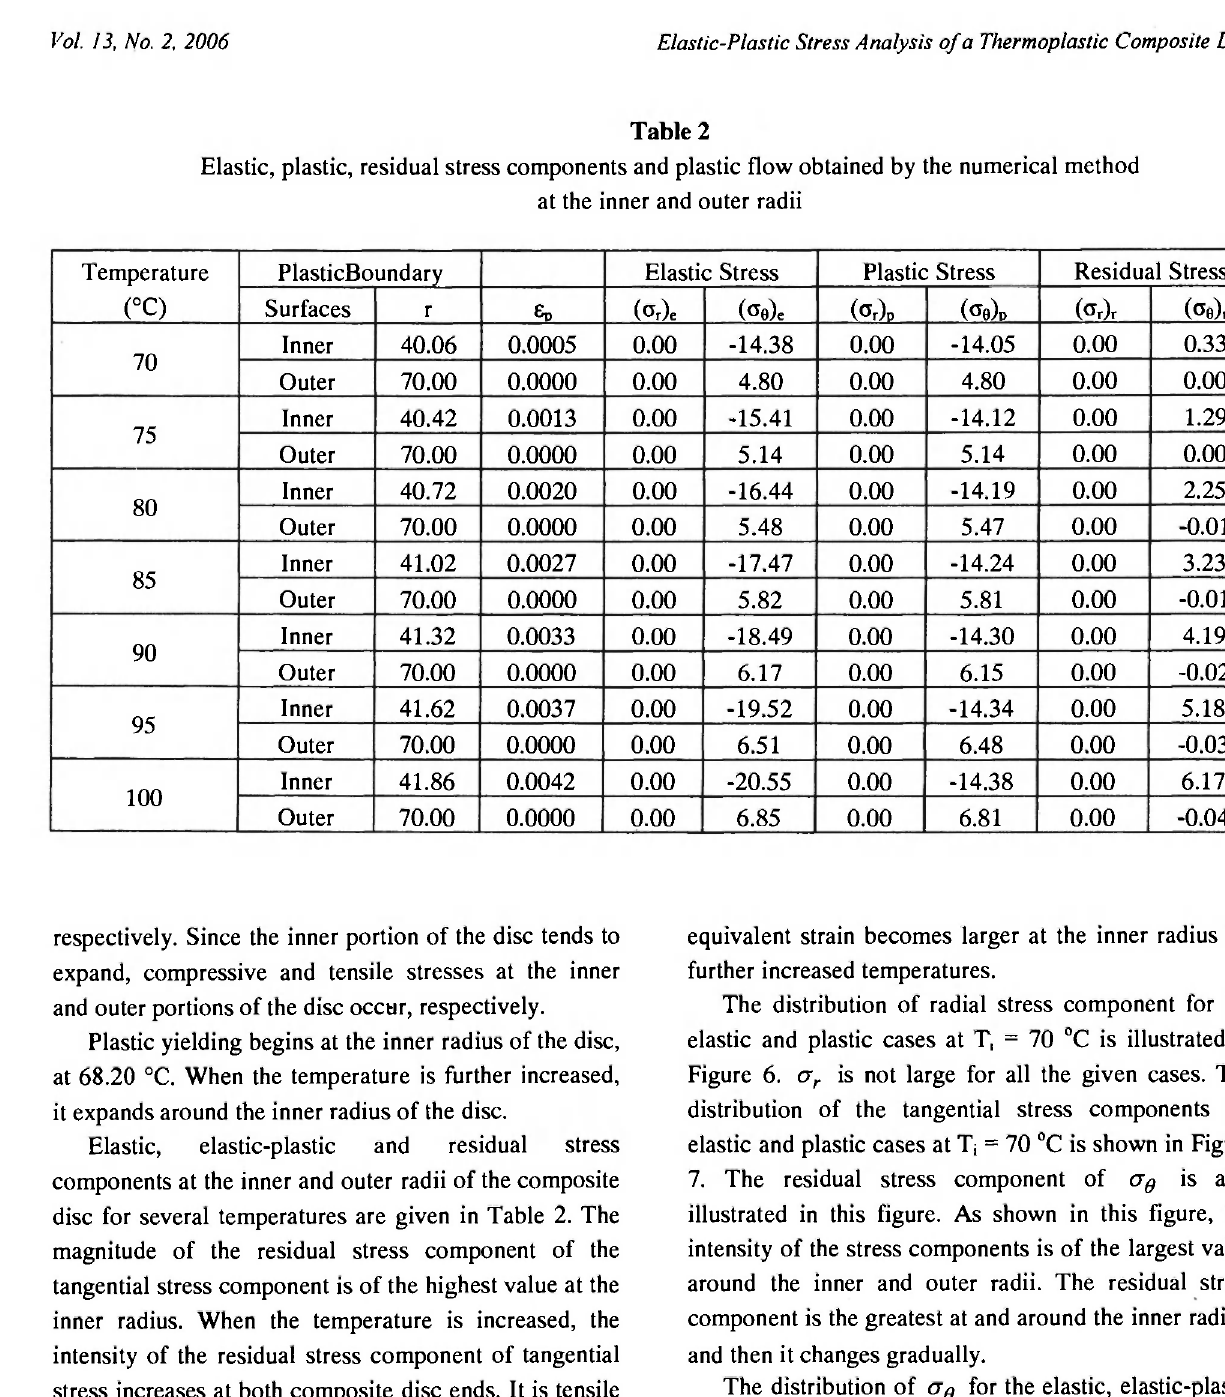
Elastic, plastic, residual stress components and plastic flow obtained by the numerical method at the inner and outer radii